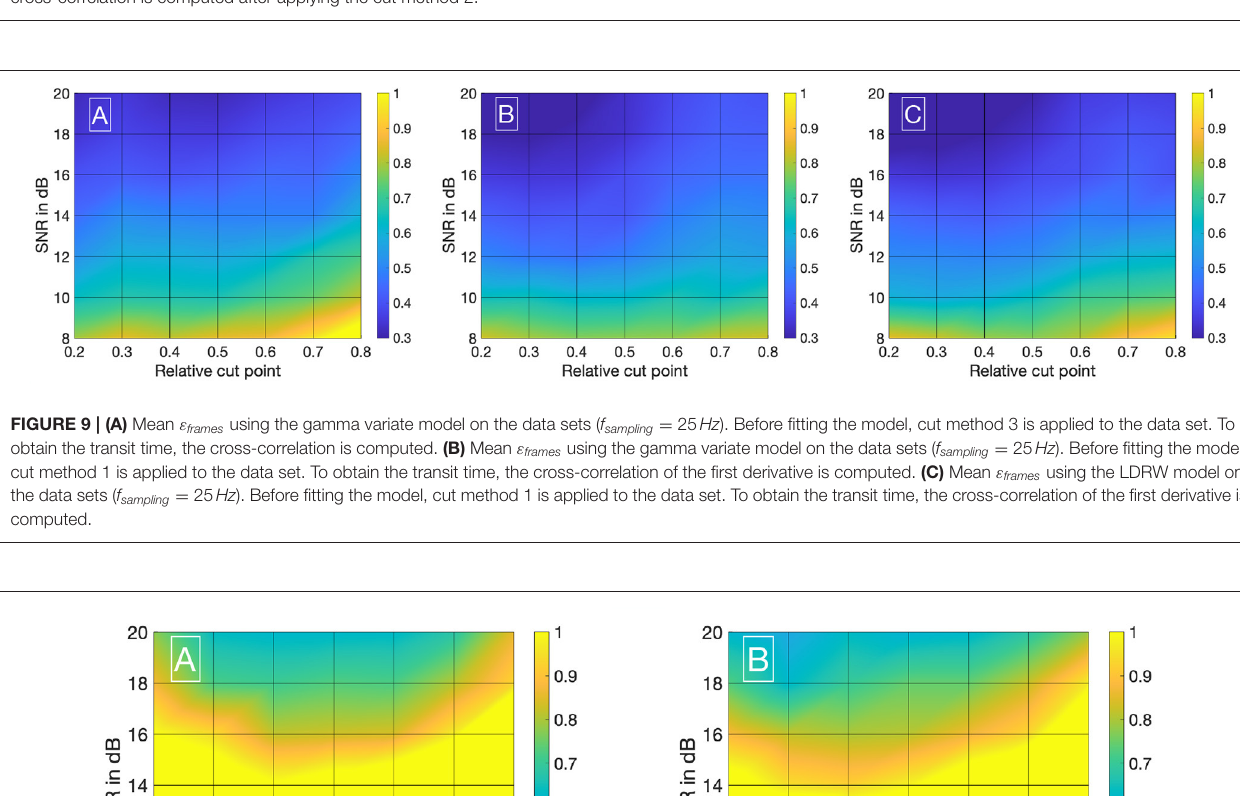
25 Hz ) with no mathematical fits. To obtain the transit time, the cross-correlation is computed after = 25 100 Hz ) with no mathematical fits. To obtain the transit time, the = ·